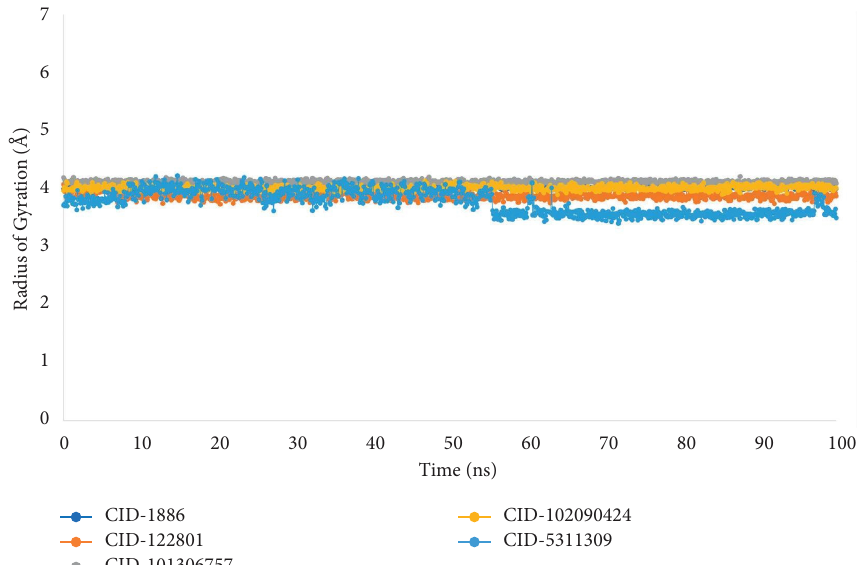
Figure 4: Te radius of gyration (Rg) of the protein-ligand interaction was calculated using the 100 ns simulation. Te markers blue, orange, gray, yellow, and light blue are used to depict the selected ligand compounds that contain the CID 1886, CID 122801, CID 101306757, CID 102090424, and CID 5311309, respectively, in association with the protein.